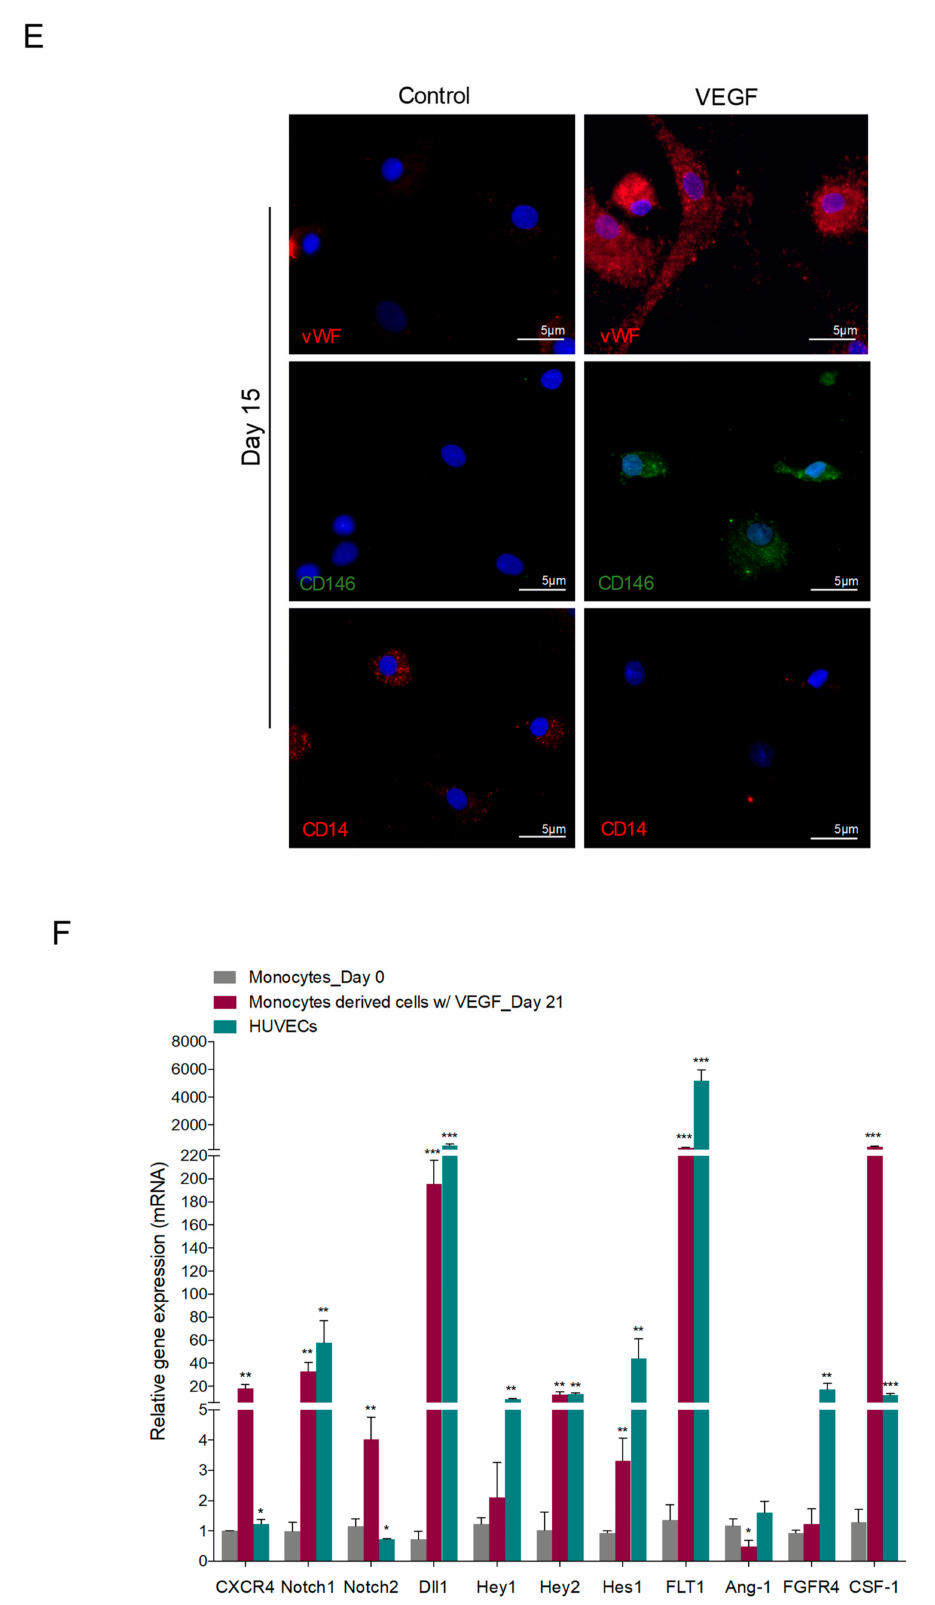
Figure 1. Cultured monocytes undergo an increase in the expression of endothelial cells (ECs) markers and acquire spindle cell like morphology, indicating EC di ff erentiation of monocytes. ( A ) MIF (median intensity fluorescence) values from Flow cytometry analysis of CD14—monocytic marker, CD31,